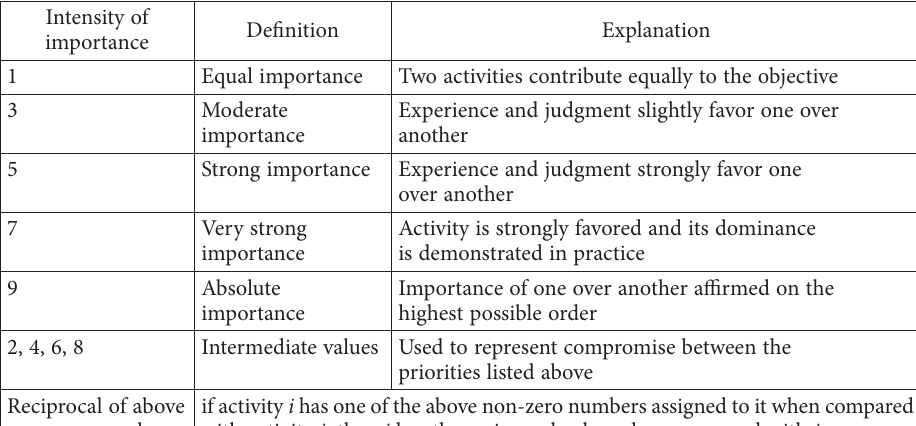
Table 5. 1–9 scale used for criteria comparisons (Saaty 1996)